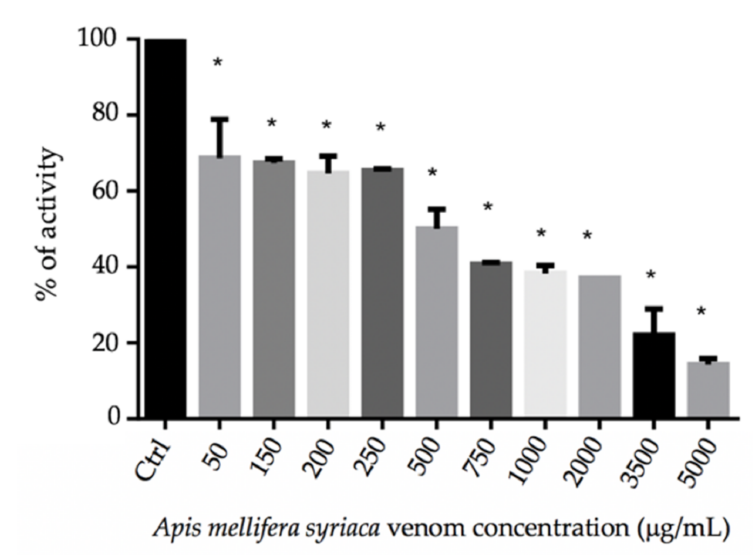
Figure 1. Percentage of plasma activity as a function of the concentration of A. mellifera syriaca venom. The results represent the mean ± SD of three independent experiments. Statistically compared with untreated cells; * p <